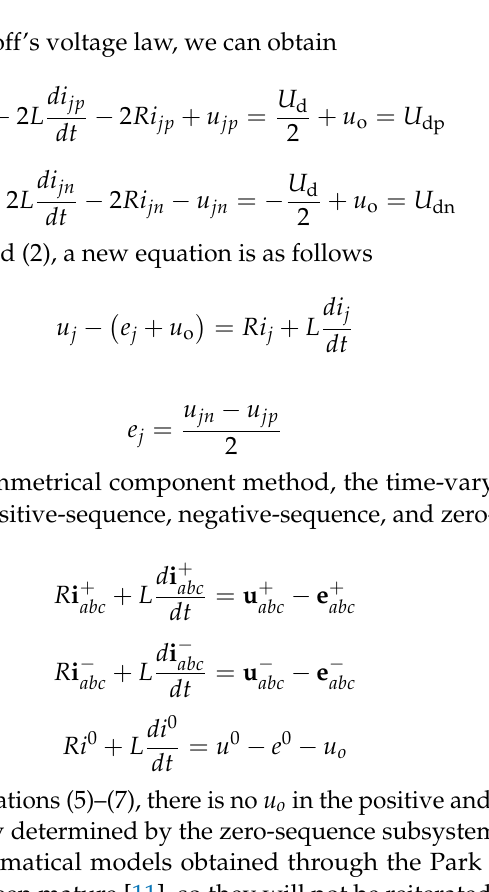
Figure 2. Schematic diagram of MMC. ( a ) Equivalent circuit of MMC. ( b ) Diagram of bridge arm. ( c ) Diagram of sub-module.